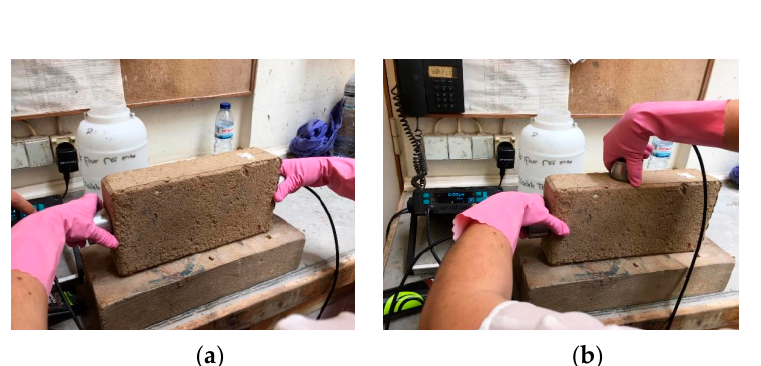
Figure 3. Ultrasonic Pulse Velocity (UPV) test—( a ) direct method and ( b ) indirect method.